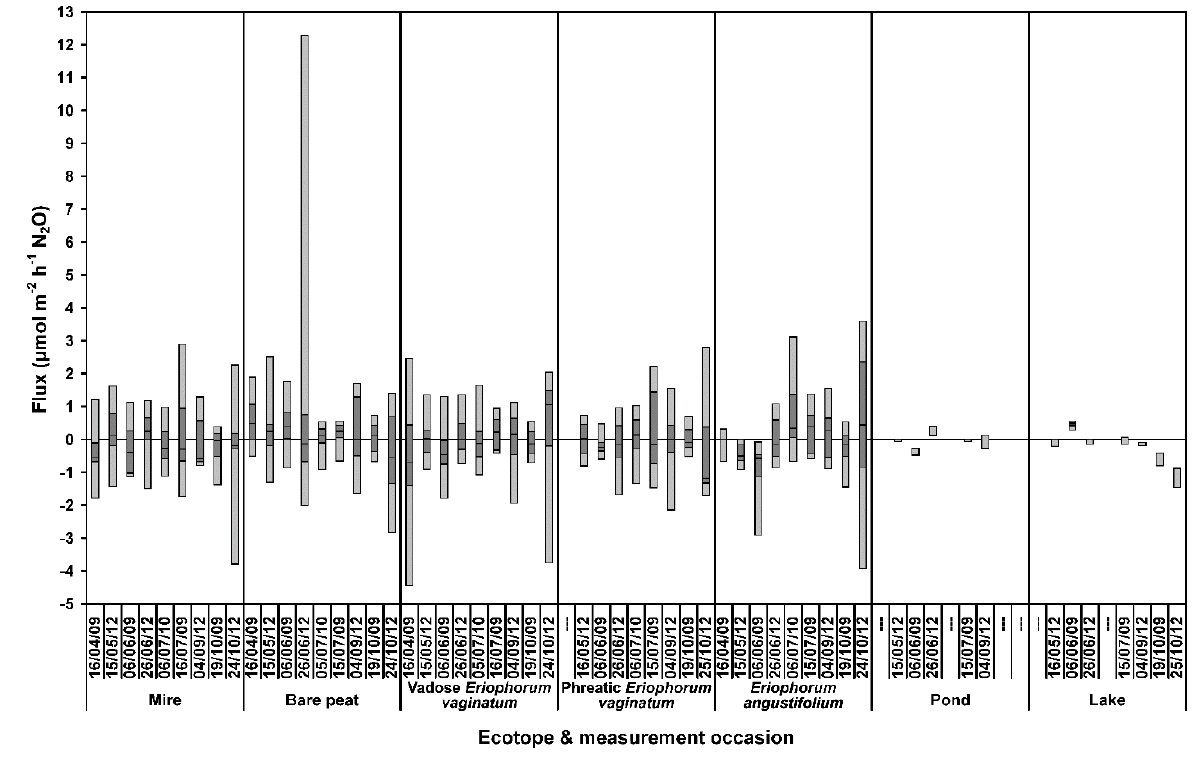
Figure 6. Nitrous oxide (N 2 O) fluxes (µmol m -2 h -1 ) within the ecotopes, shown in quartiles (bars) and listed in order of seasons. Positive values indicate fluxes from the peatland to the atmosphere and negative values indicate fluxes from the atmosphere to the